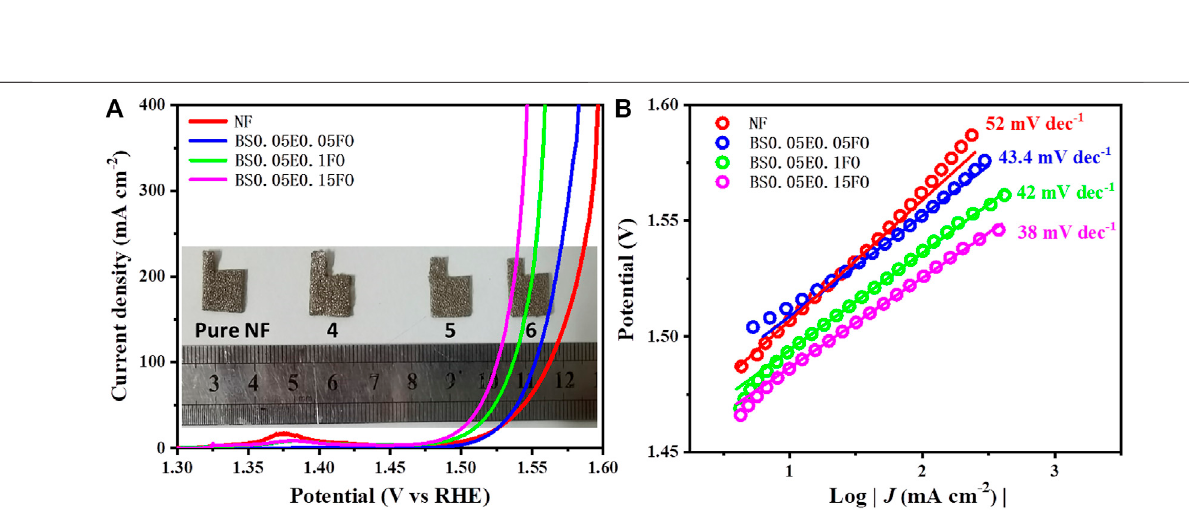
Frontiers in Physics |